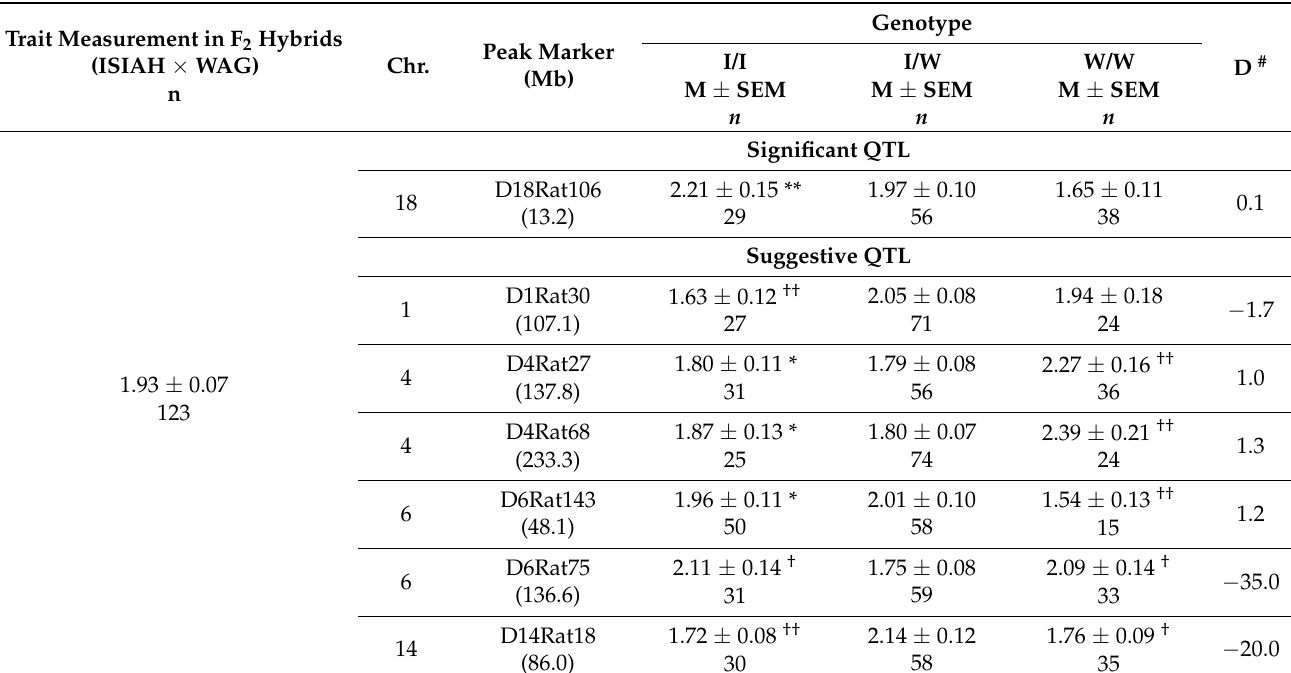
Table 3. Allele effects in QTL associated with concentration of norepinephrine in the hypothalamus in male rats F 2 (ISIAHxWAG) aged 6